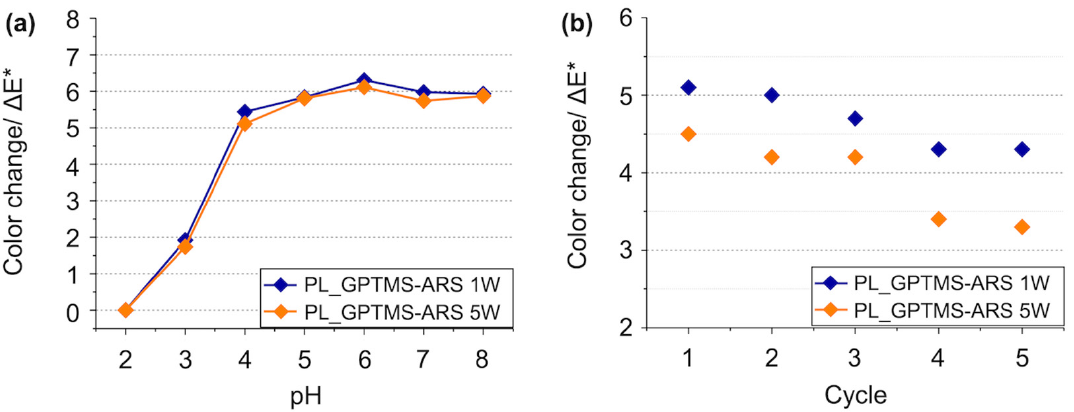
Figure 5. Δ E* color change with respect to pH 2 of PL_ARS, PL_GPTMS-ARS after 1 and 5 washing cycles (blue and orange curves, respectively) as a function of pH variations ( a ) and repeated cycles ( b ).